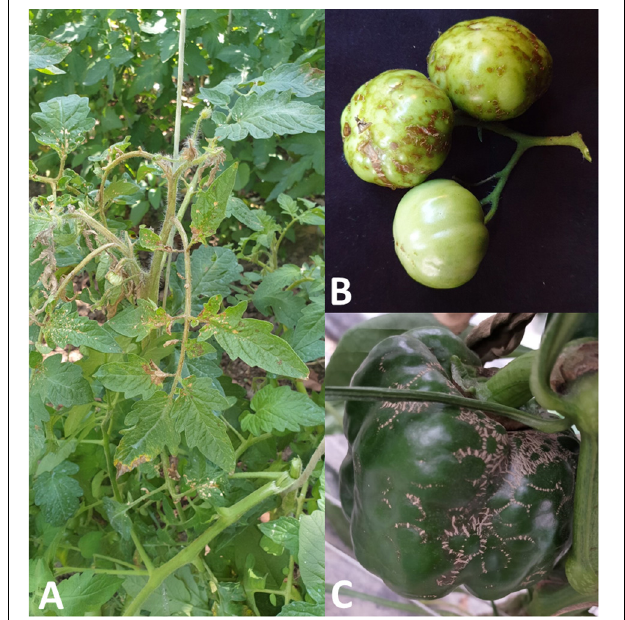
FIGURE 1 | Symptoms induced by PMoV in tomato and pepper: (A) basal irregular necrotic lesions of tomato leaflets, longitudinal necrotic stripes of the stem and necrosis of the apex; (B) greenish translucent rings and corky brownish rings on deformed tomato fruits; (C) brownish corky rings and fruits deformations in